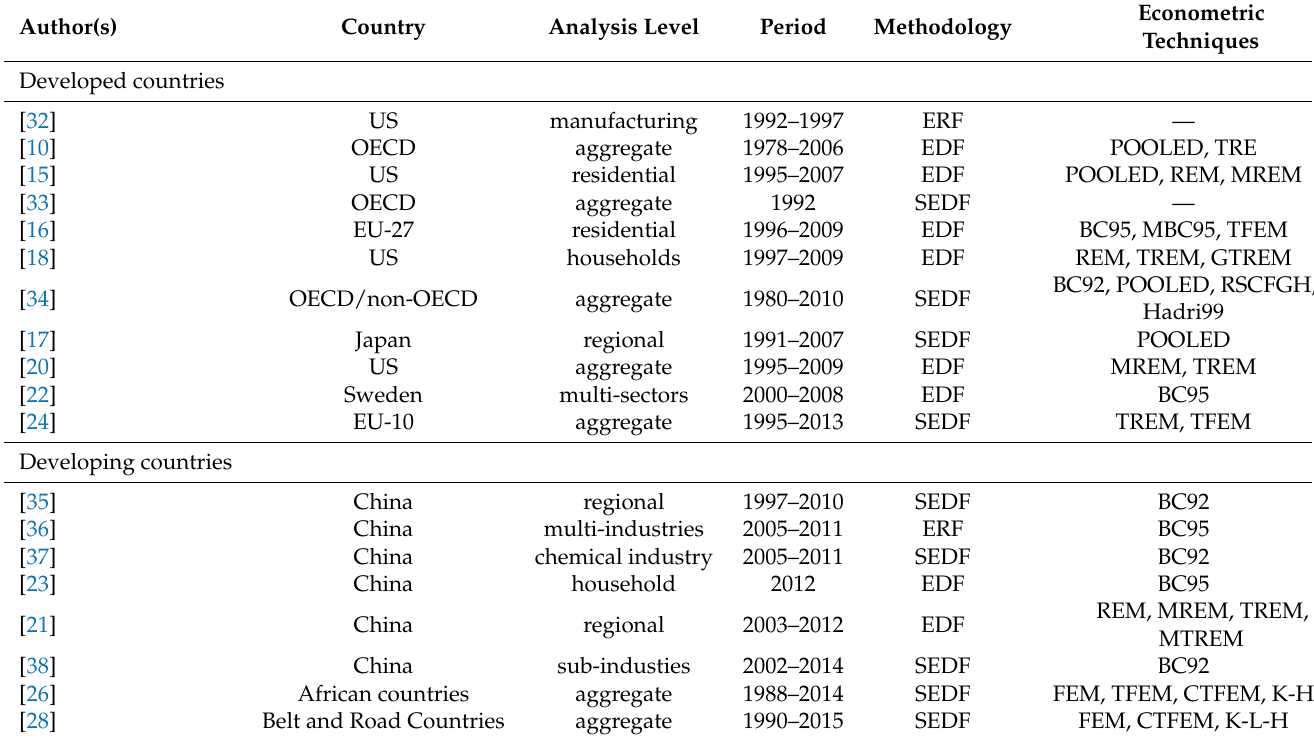
Table 1. Summary of cited SFA studies on energy